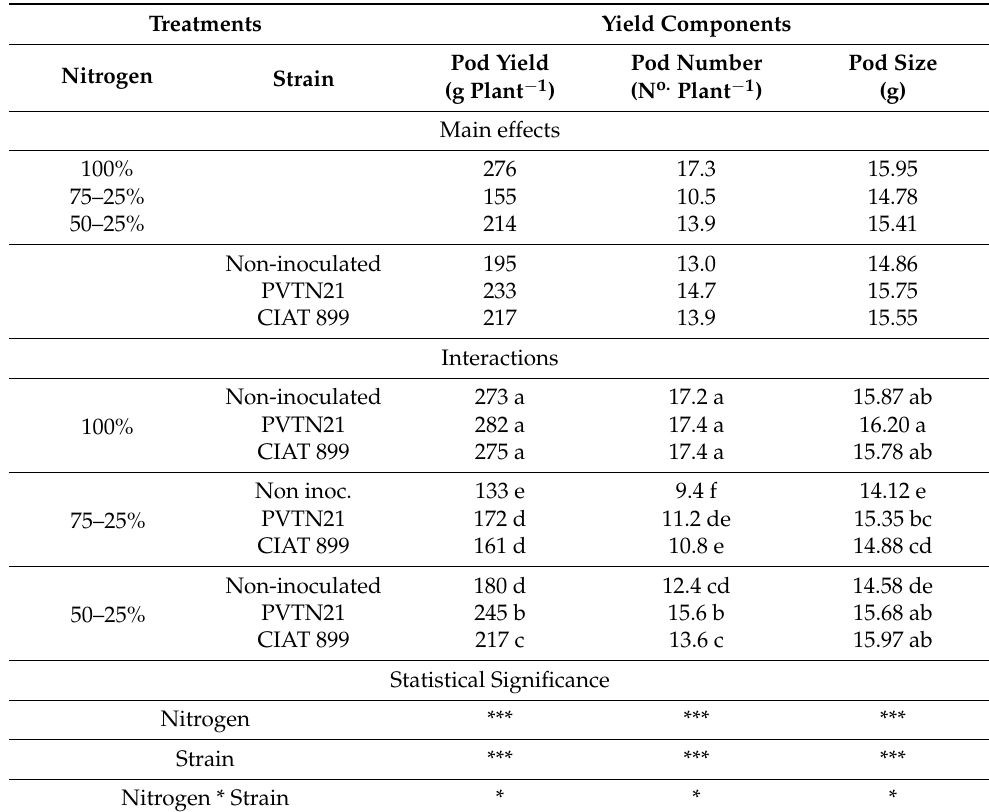
Table 4. Average pod weight (g), pod number (number plant − 1 ) and total fresh-pod-yield (g plant − 1 ) of the common bean ( Phaseolus vulgaris L.) in response to the varying quantities of inorganic-N application (100%, 75–25, or 50–25%), and/or inoculation with rhizobia strains (PVTN21 or CIAT899). Treatments Yield